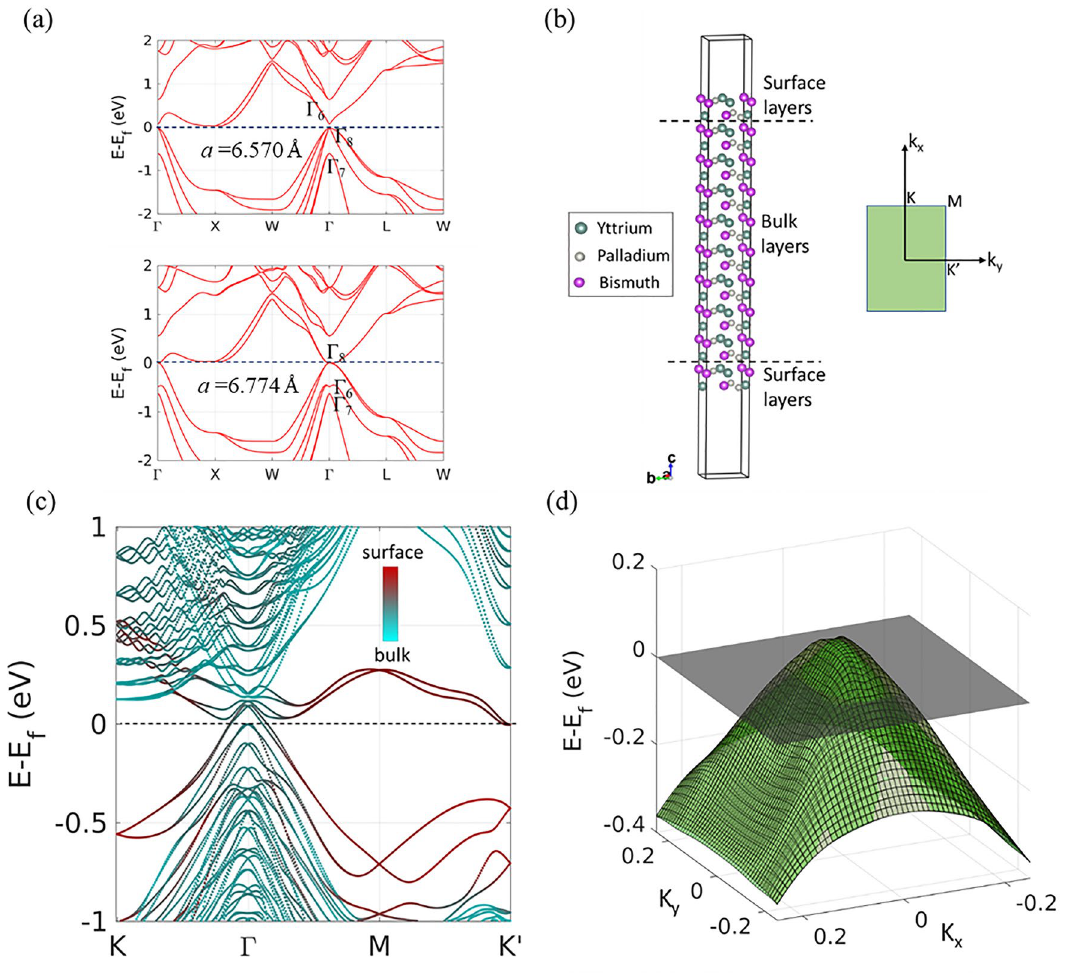
Figure 5. DFT-based first principles calculations: ( a ) Electronic band structure calculated with equilibrium lattice constant 6.570 Å and strained lattice constant 6.774 Å. ( b ) Lattice structure of semi-infinite (110) oriented slab of YPdBi with vacuum on both sides. ( c ) The K-resolved density of states showing contribution from surface atoms. Red color represents the contribution of atoms from the surface layers and cyan color represents the contribution from bulk layers. ( d ) Energy dispersion of two bands crossing the Fermi